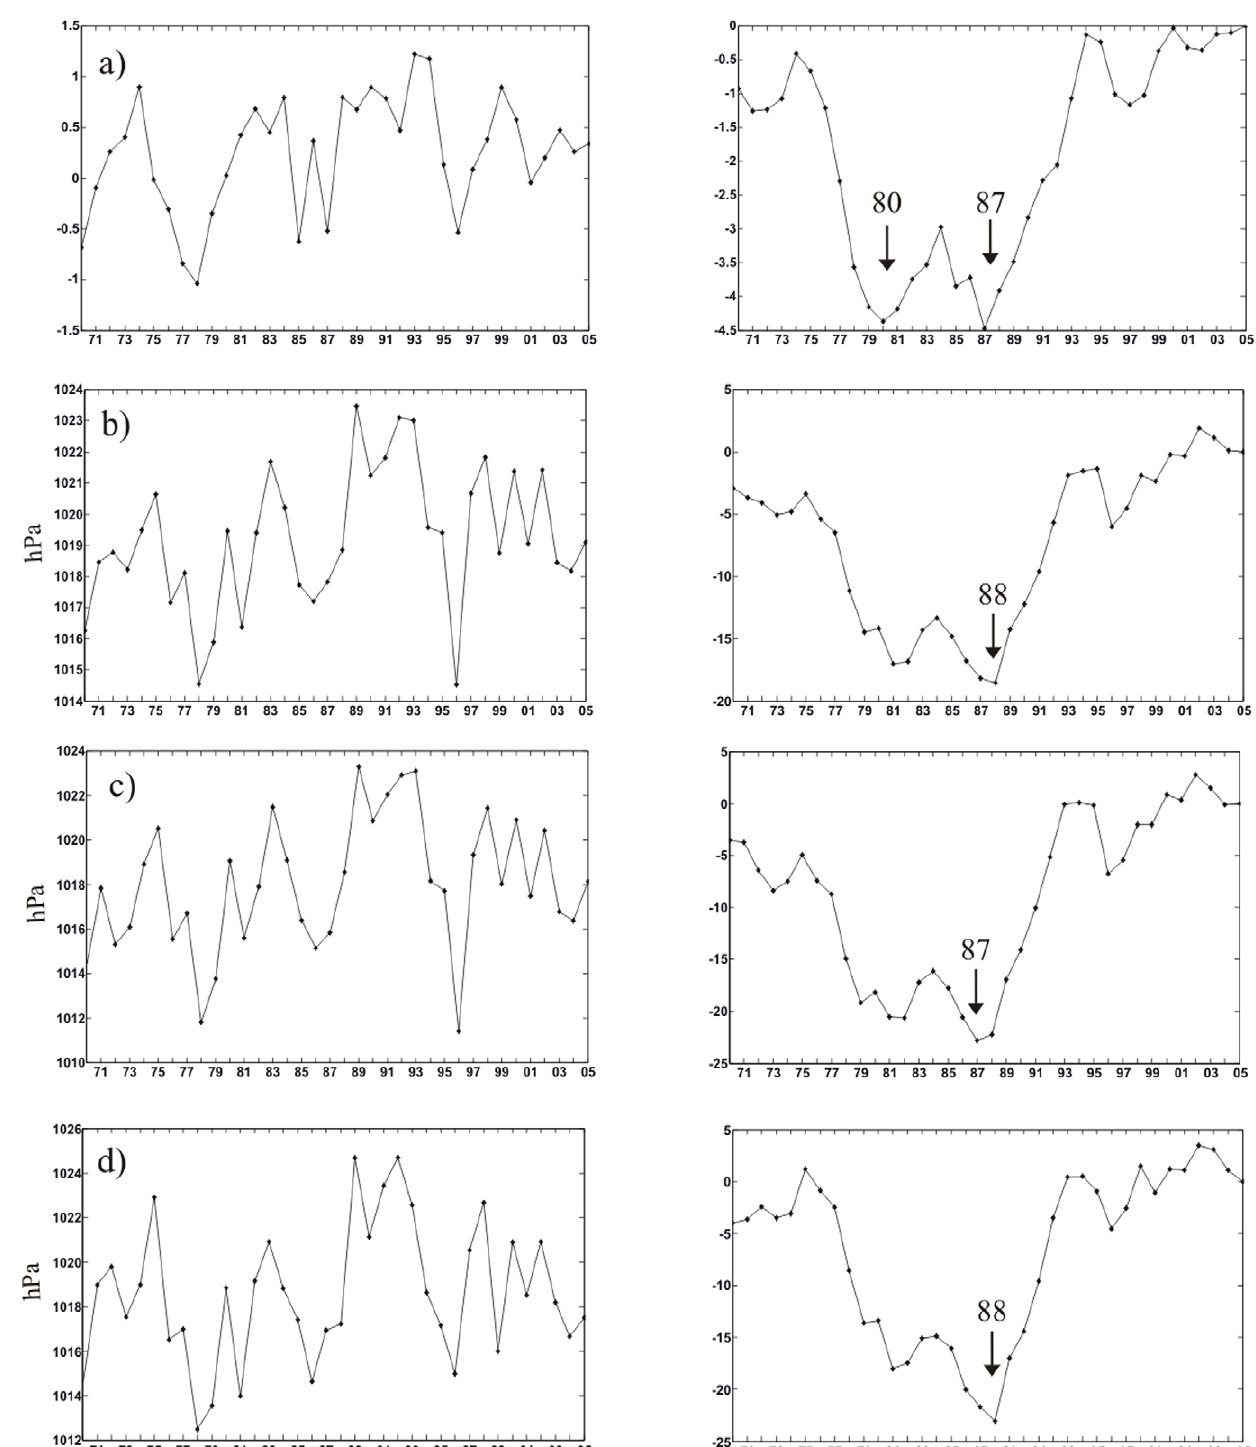
Figure 4. Time Series (left panel), and Cumulative Sums (right panel) of pressure based variables, over 1970–2005. a) winter North Atlantic Oscillation (NAO) index; b) winter average SLP over the Mediterranean basin; c) winter average SLP over the north-western Mediterranean; d) winter SLP in the Gulf of Trieste. In the cumulative sum panels the year of change is indicated by an arrow.